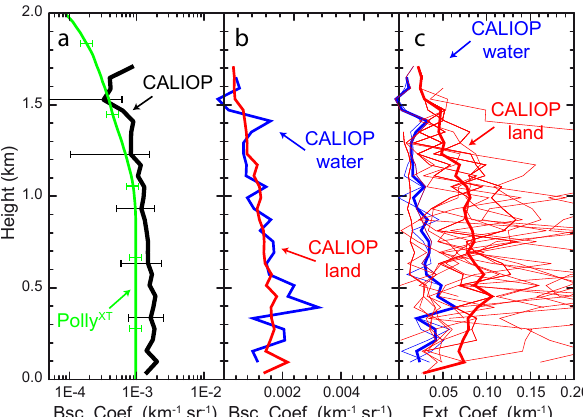
Figure 4. (a) Mean vertical profiles of the particle backscatter coefficient at 532nm as determined with Polly XT (green) from 03:45 to 05:00UTC and CALIOP at around 04:47UTC on 13 Jan- uary 2010. The CALIOP backscatter profiles are based on cloud- free signal profiles (black). (b) Averaged cloud-free profiles of the particle backscatter coefficient at 532nm over land (red) and over water surface (blue) determined from CALIOP measurements. (c) Averaged cloud-free profiles of the extinction coefficient at 532nm (thick lines) and individual profiles (thin